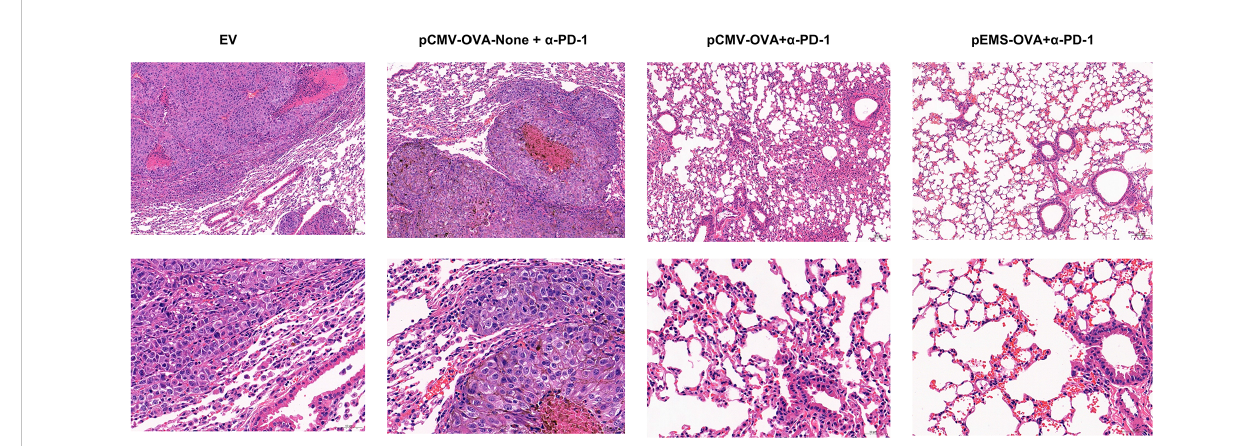
FIGURE 5 H&E staining of lungs collected from the treated B16F10-OVA-bearing mice. Representative H&E staining images of lungs isolated from B16F10- OVA-bearing mice following treatment with a combination of different DNA vaccination and intramuscular gene transfer of PD-1 antibody. H& E staining, hematoxylin and eosin